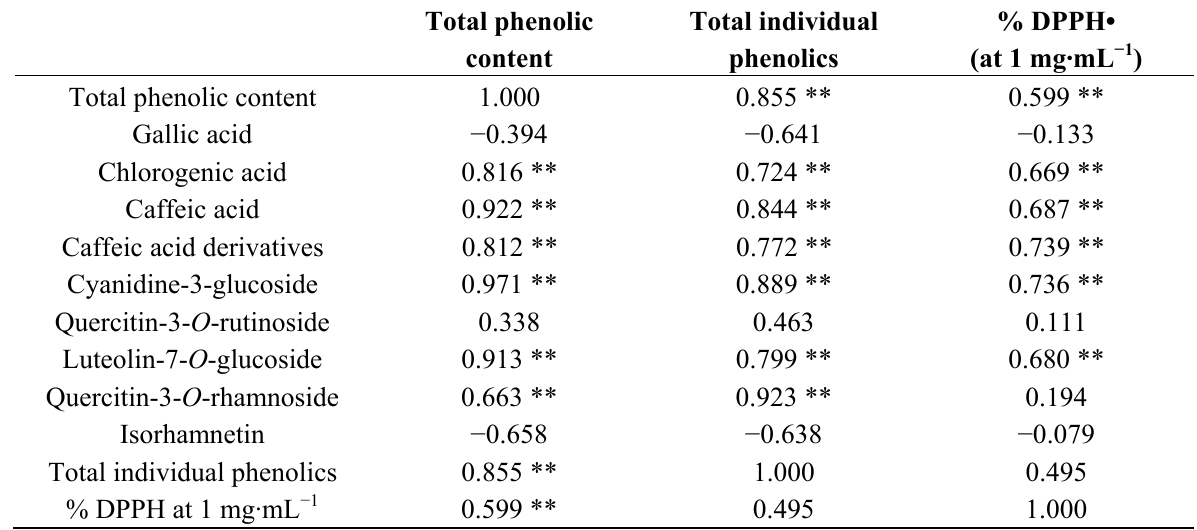
Table 5. Coefficients and degrees of significance of Pearson correlations between the different parameters 1